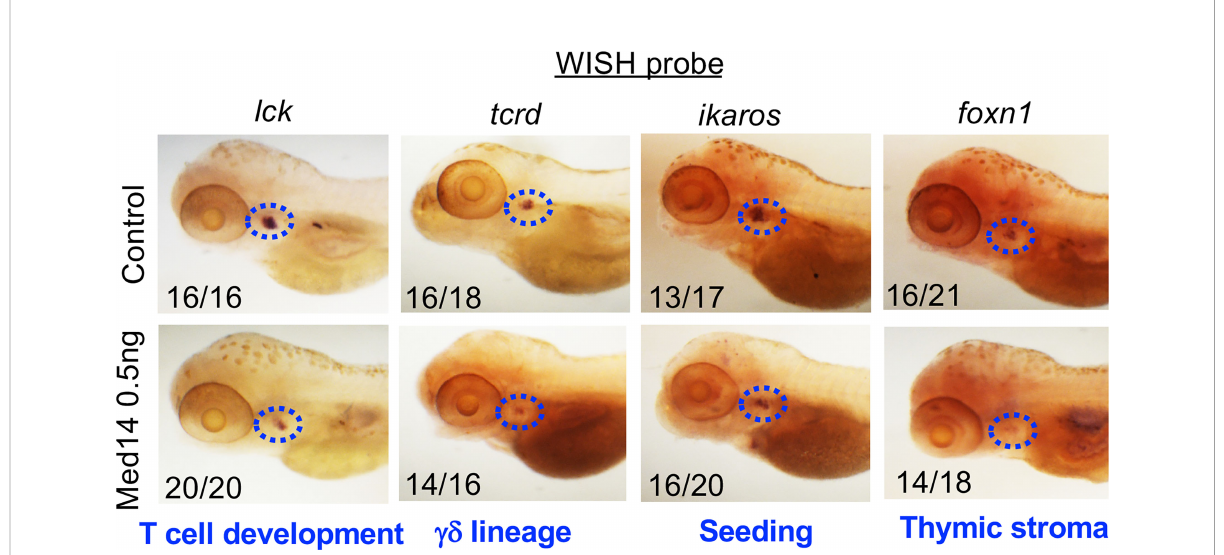
FIGURE 3 Role of MED14 in Development of Thymic Subpopulations in Zebra fi sh. The effect of med14 knockdown on cell subpopulations was evaluated at 5 dpf by performing WISH on TLF zebra fi sh embryos with the indicated probes: lck marks most developing thymocytes, ikaros marks thymic seeding progenitors, tcrd marks gd lineage progenitors, and foxn1 marks thymic epithelial cells. Blue ovals mark the thymus and frequencies of embryos with the exhibited staining pattern are indicated at the lower left of each image. Data are representative of 3